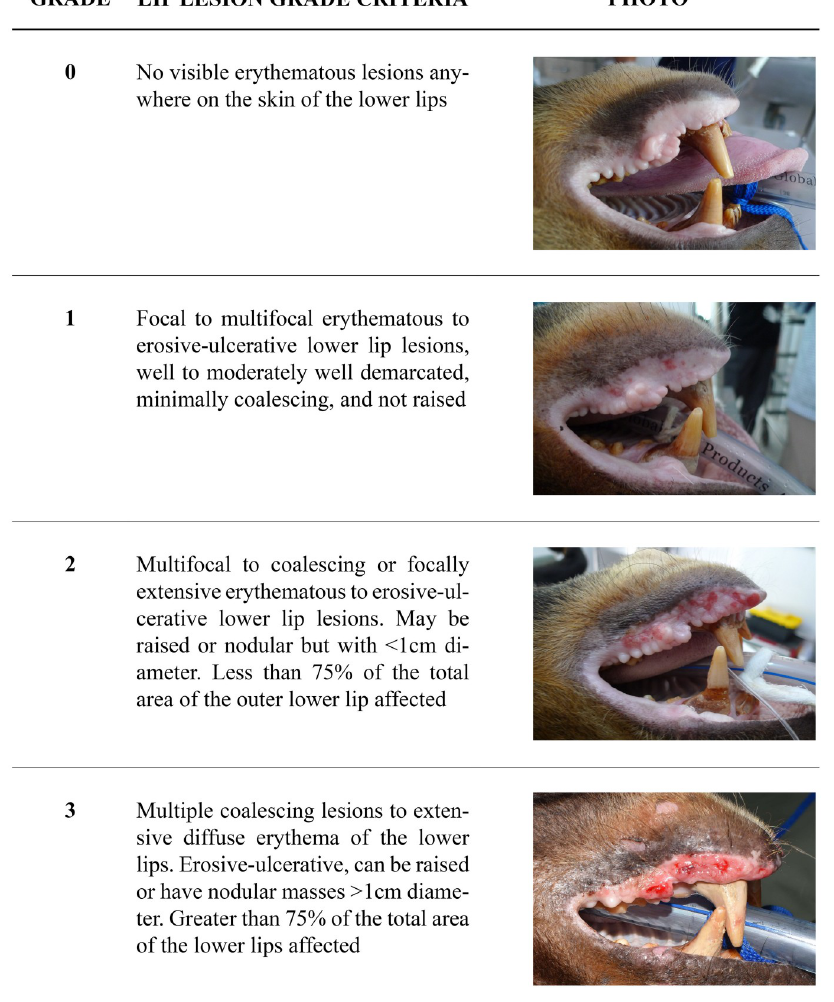
Fig 1. Sun bear ( Helarctos malayanus ) lip lesion severity